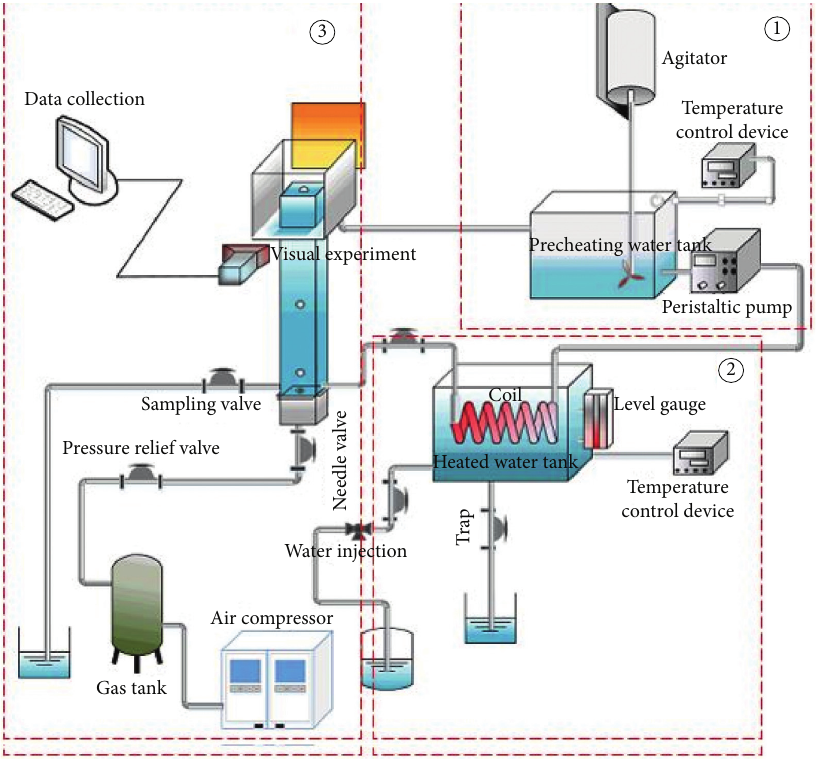
Figure 1: Schematic diagram of experimental system.